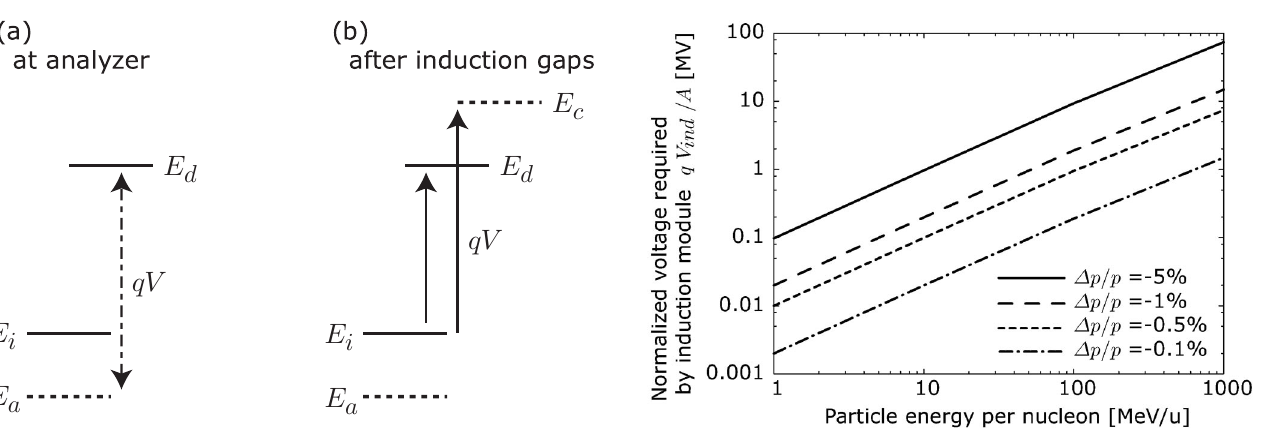
FIG. 4. Voltage required at an induction modulator as a func- tion of particle energy per nucleon at each momentum error before the correction.